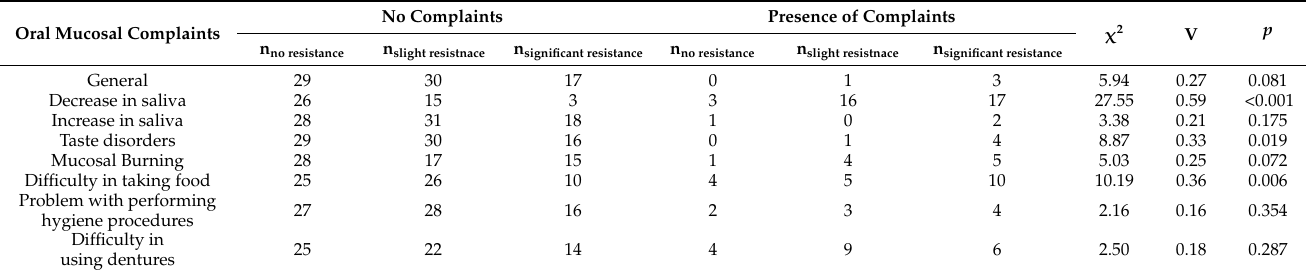
Table 13. Analysis of the relationship between mucosal complaints and the score of the mirror test in the study